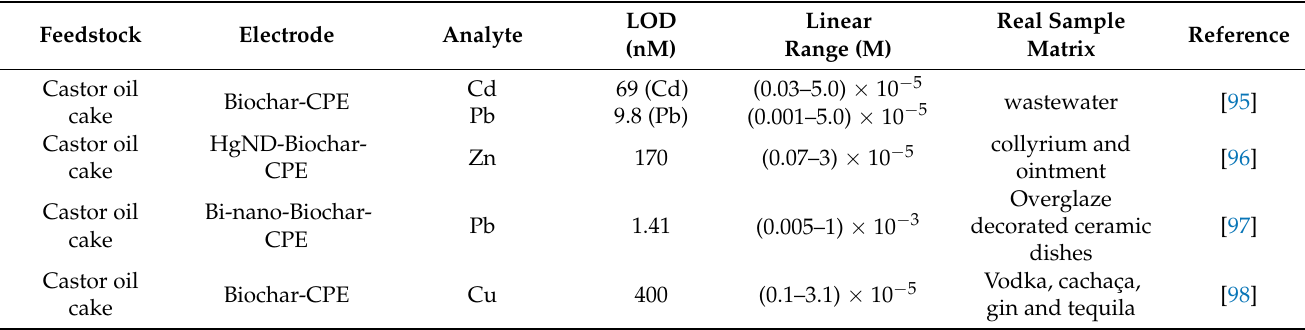
Table 4. Main source, preparation, application and limit of detection (LOD) obtained from biochar- modified CPE and